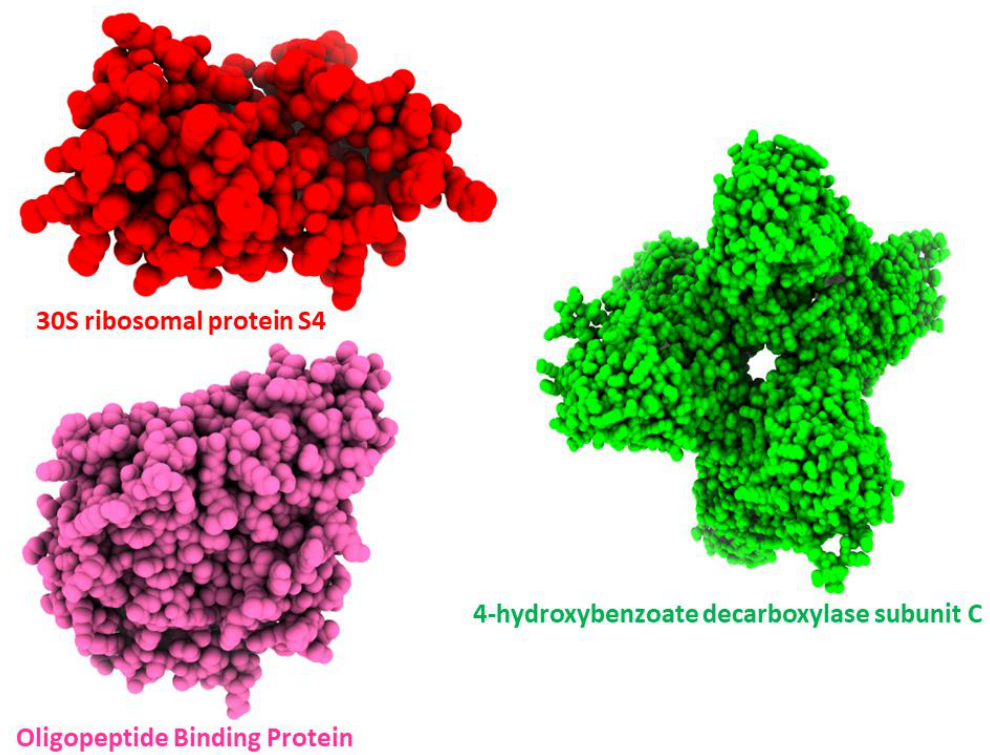
Figure 2. Graphical representation of 3D Structures of the Proteins.